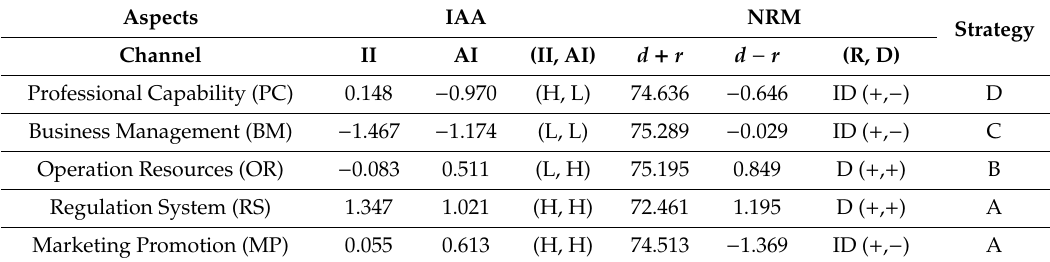
Figure 5. The NRM for channels. Table 14. The development strategy for channels.